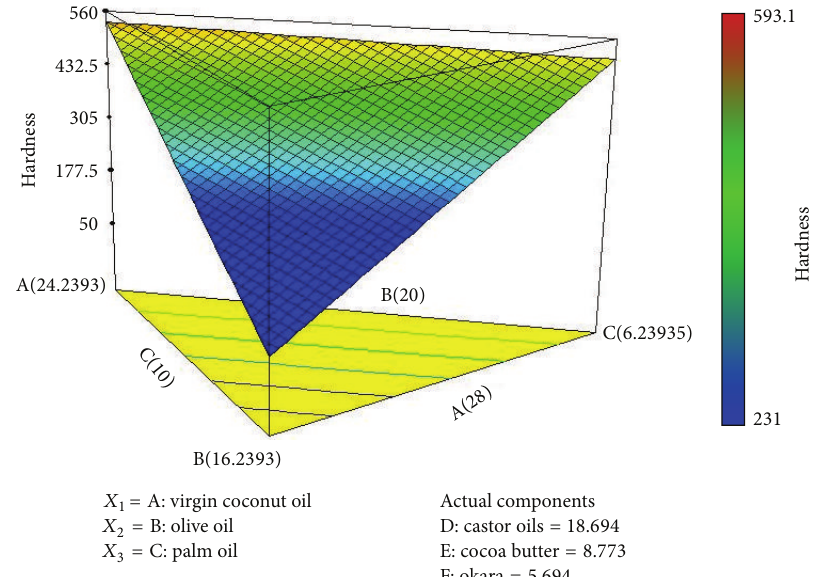
Figure 3: Three-dimensional diagram illustrating the effect of the different fatty acid and oils on the response ( 𝑌 ), hardness (N).